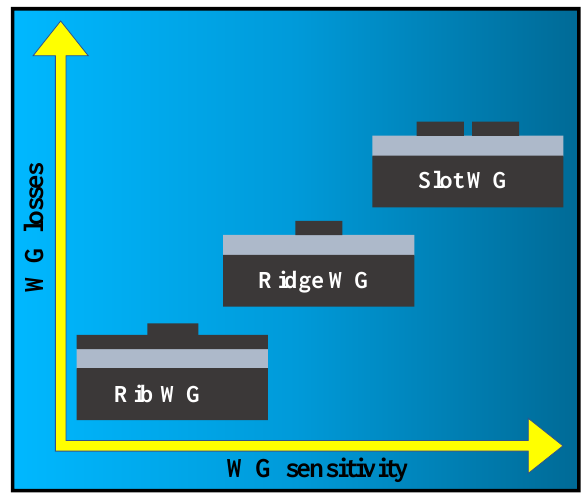
Figure 3. Widely used SOI WG geometries for optical biosensing.